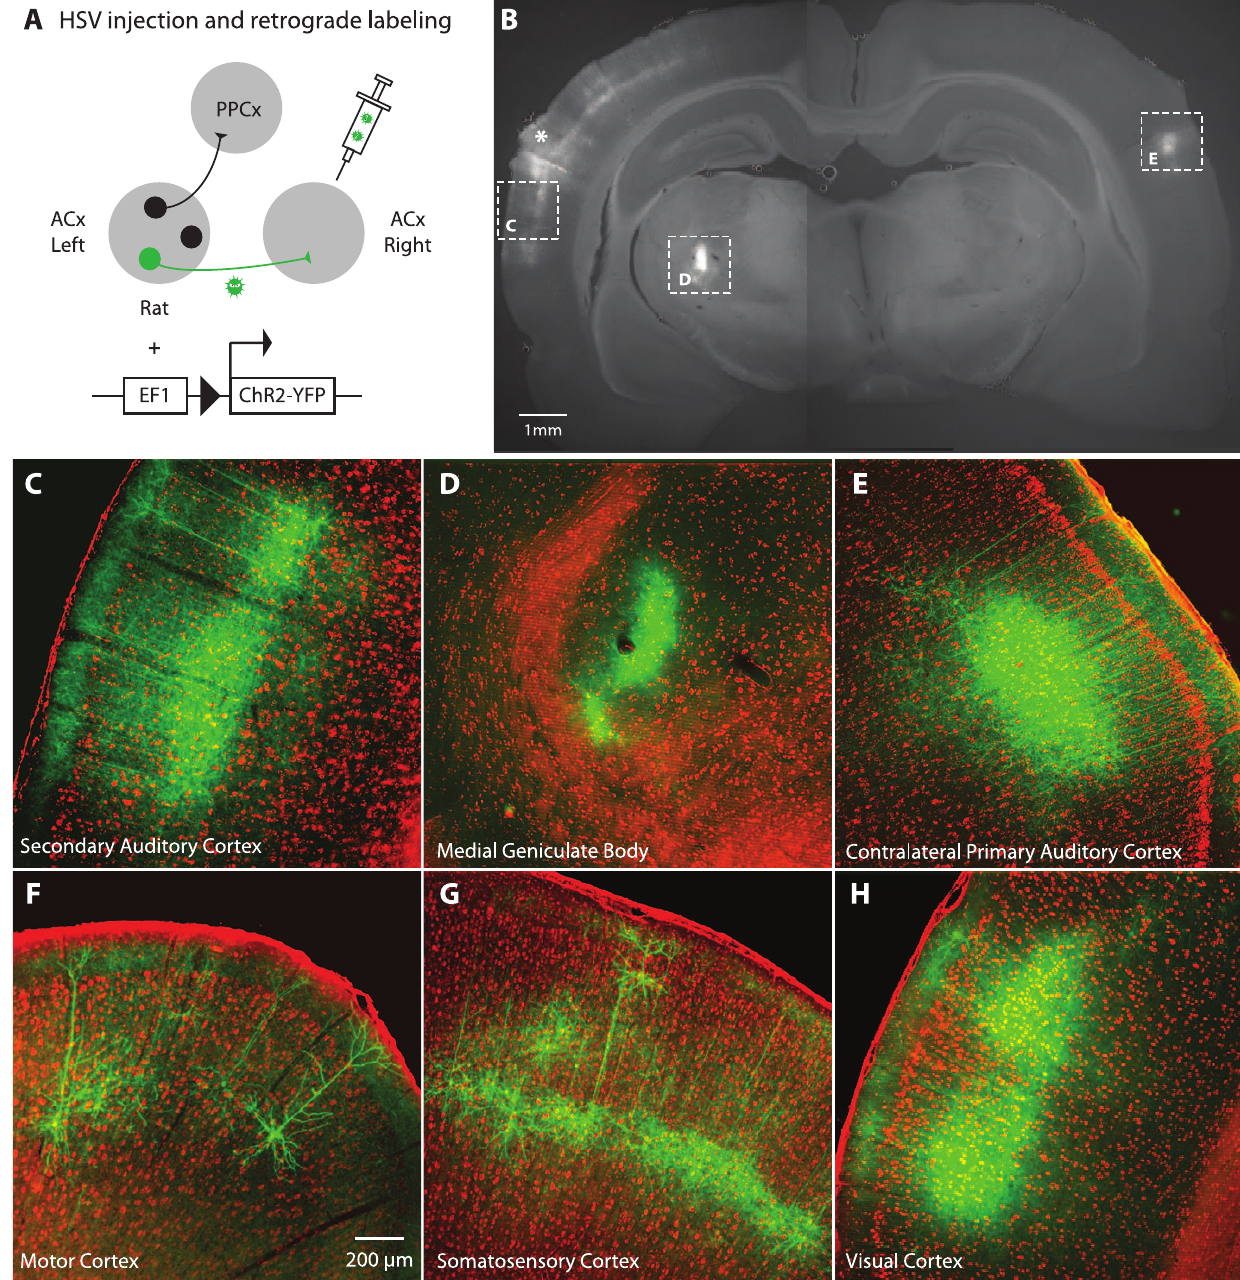
Figure 3. Viral mediated retrograde labeling of neurons projecting to the primary auditory cortex. (A) To tag neurons based on projection pattern, HSV1 expressing ChR2-YFP was injected into the right auditory cortex. Ten days later, coronal brain sections were made to assess infected cells ( green ); sections were counterstained with red fluorescent Nissl substance to stain neurons. (B) Coronal section showing the site of injection ( asterisk ) and ipsilateral secondary auditory cortex ( above left box ). Staining can also be seen in the auditory thalamus ( middle box ) and contralateral auditory cortex ( right box ). Retrogradely labeled areas include: (C) nearby ipsilateral secondary auditory cortex; (D) ipsilateral medial geniculate (auditory) thalamus; (E) neurons in layers 3 and 5 of the contralateral primary auditory cortex; (F) motor cortex; (G) somatosensory cortex; (H) visual cortex. doi:10.1371/journal.pone.0006099.g003 suitable target for photostimulation. We therefore injected HSV1- In vivo photostimulation of callosally-projecting neurons. Injection of HSV1-ChR2-YFP into the auditory ChR2-YFP into the right primary auditory cortex, and recorded cortex of the rat led to a high density of ChR2-YFP expression light-evoked activity in area A1 of the contralateral (left) cortex at in layers 3 and 5 of the contralateral auditory cortex (Figure 3). We least 8 days after injection. To record and photostimulate rat layer reasoned that these callosally-projecting neurons would be a 3 and 5 pyramidal neurons whose axons project to the